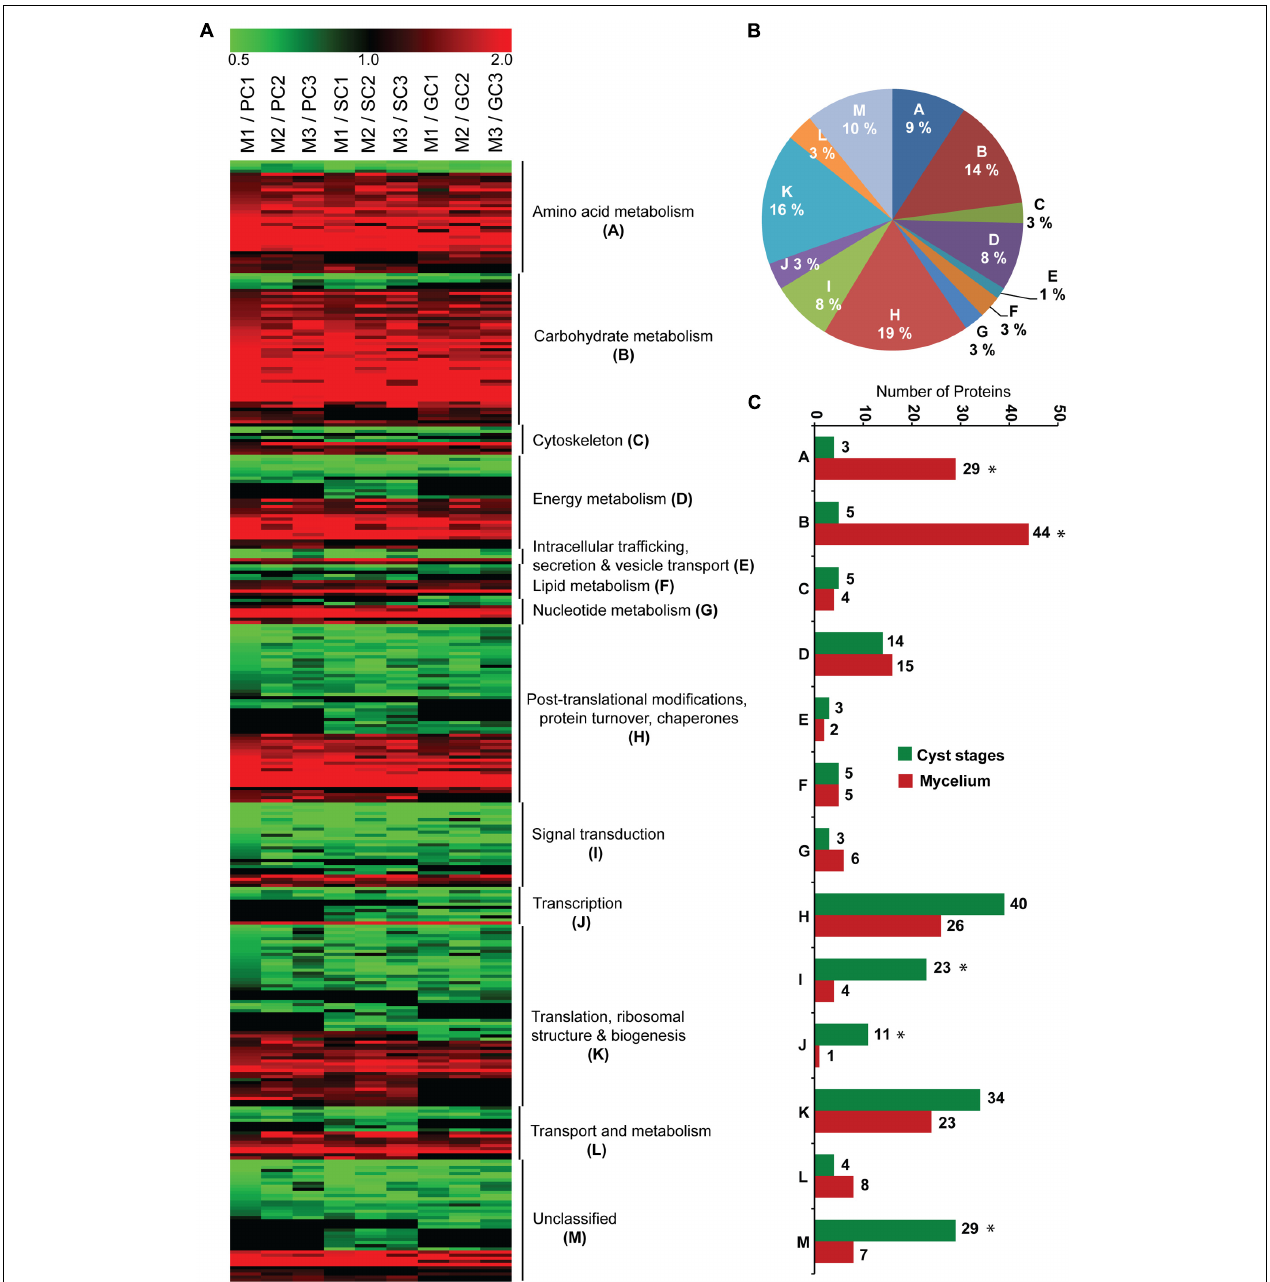
FIGURE 3 | Distribution of functional classification among enriched proteins. (A) Heat map illustrating the relative abundance of the significantly enriched proteins in the mycelium (red) and different cyst stages (green) in all three biological replicates. Missing values are shown in black; (B) proportional representation of each functional classification among the proteins enriched in the mycelium and different cyst stages of S. parasitica combined; (C) total number of significantly enriched proteins, associated with each functional category, in the mycelium (red) and different cyst stages (green) of S. parasitica. The asterisks mark the functional categories of proteins that present significantly different levels of expression between the mycelium and cyst stages ( p < 0.05; Chi-square